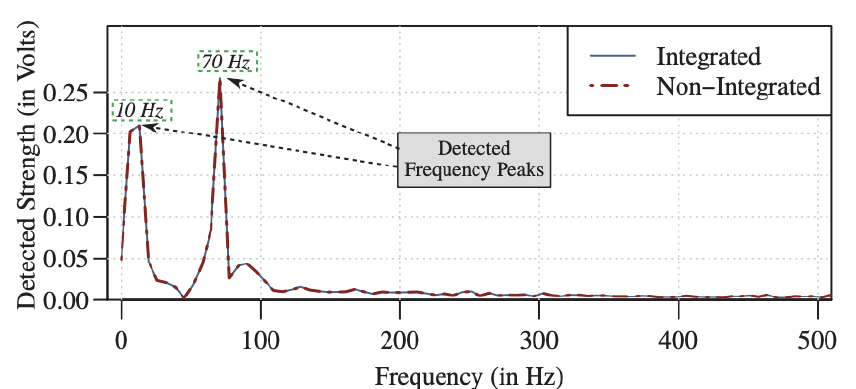
Figure 12. Process of implementation [59].